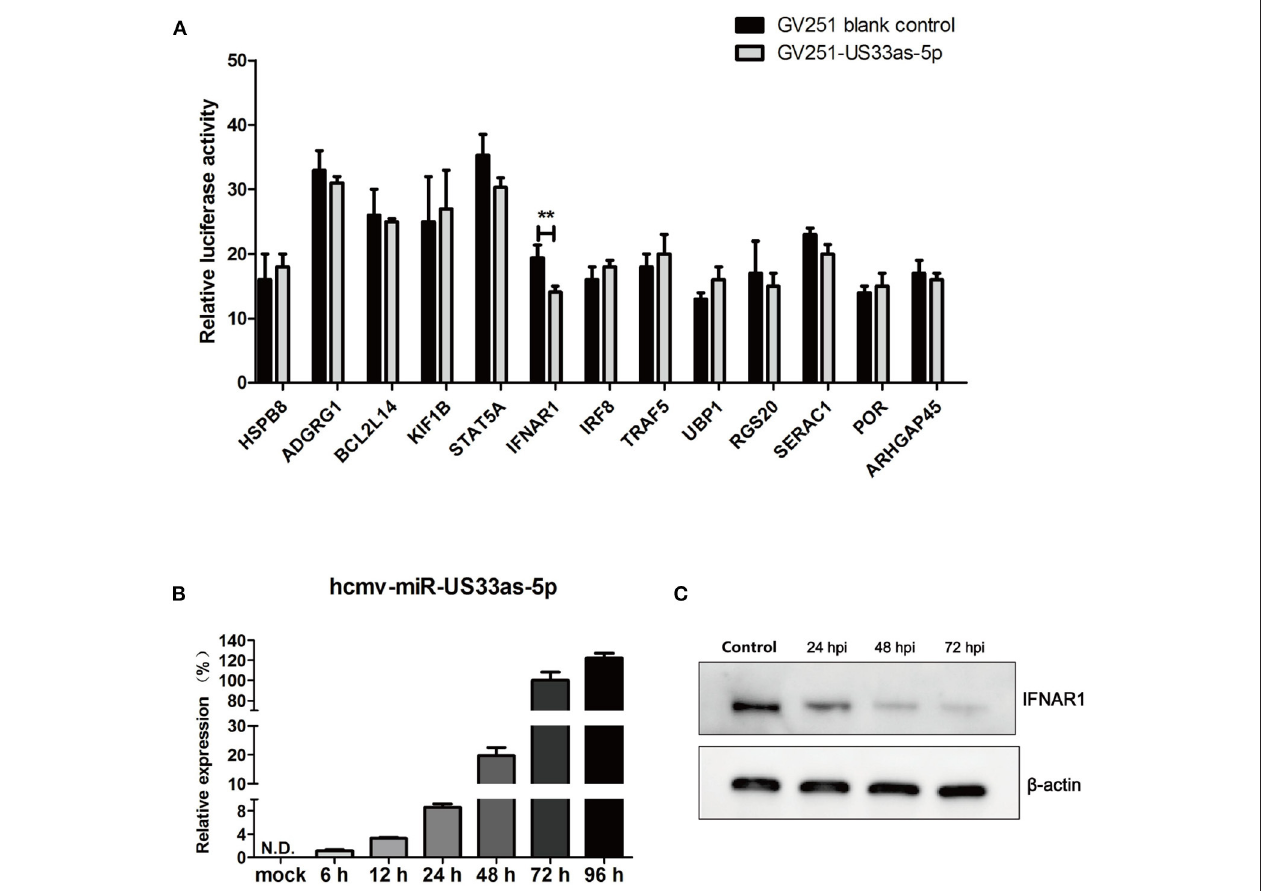
FIGURE 1 | hcmv-miR-US33as-5p inhibited the expression of IFNAR1 by targeting the 3 ′ -UTR of IFNAR1. (A) Reporter vectors containing the 3 ′ -UTRs of 13 predicted target genes were co-transfected with GV251 blank vector or vector containing US33as-5p into 293 cells. The dual-luciferase reporter assay was used to determine the relative Renilla luciferase activity normalized to firefly luciferase activity in cells in the corresponding wells at 48h post-transfection (hpi) when cell lysates were harvested. (B) The expression of hcmv-US33as-5p during HCMV infection at different time points was determined by qPCR. U6 was used as a loading control. (C) IFNAR1 protein expression at different time points after the transfection of US33as-5p mimics was examined by western blot analysis. The sample of the control group comes from cells transfected with NC-RNA for 72h. β -Actin was used as a loading control. The assays were performed in triplicate wells, and data were collected from two different experiments and are represented as the means ± SDs; ** p <